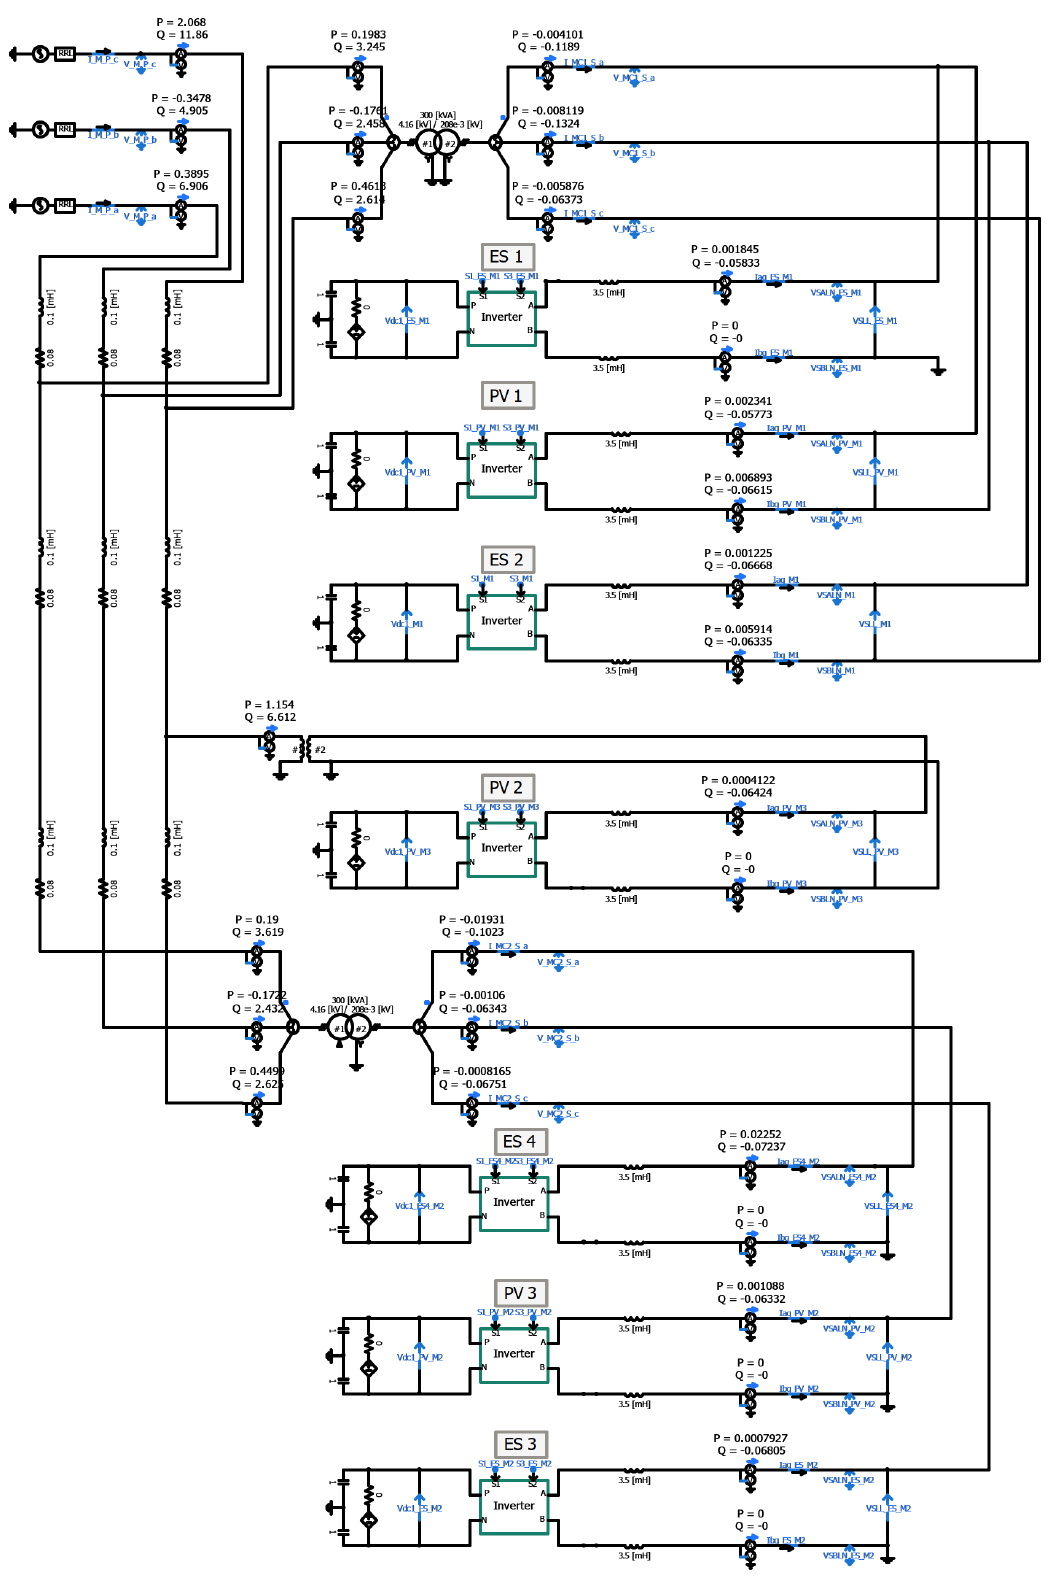
Figure 10. PSCAD model of the multimicrogrid systems. The multimeters display the initial active and reactive power flow (in kW and kvar) of the circuit with no power injection from PVs and